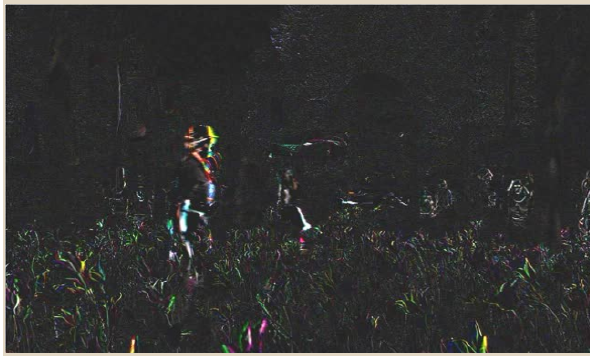
Figure 3. Temporal information